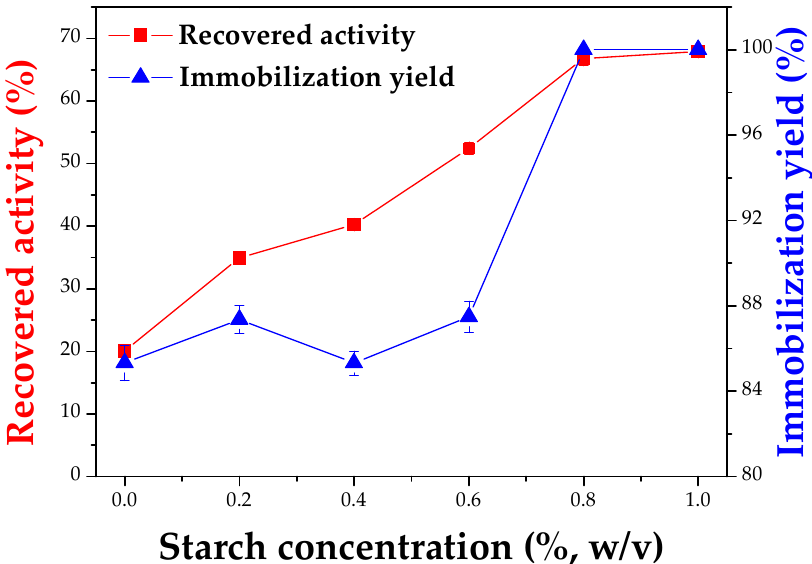
Figure 5. Effect of starch concentration on immobilization yield and recovered activity of PPL CLEAs. Assay conditions: treatment of PPL surface with dodecyl aldehyde (PPL/dodecyl aldehyde mass ratio of 1:1), precipitation with ethanol (enzyme solution/ethanol volume ratio of 1:3), co-aggregation with co-feeder (PPL/BSA/SMNPs mass ratio of 1:1.5:1.5 and starch concentration from 0.2 to 1%, w / v ), crosslinking with glutaraldehyde (5 μ moles of glutaraldehyde/mg total protein), temperature of 4 °C, 30 min precipitation/aggregation and 2.5 h crosslinking stirred at 150 rpm and incubation with α -amylase at 25 °C stirred at 150 rpm for 2 h.